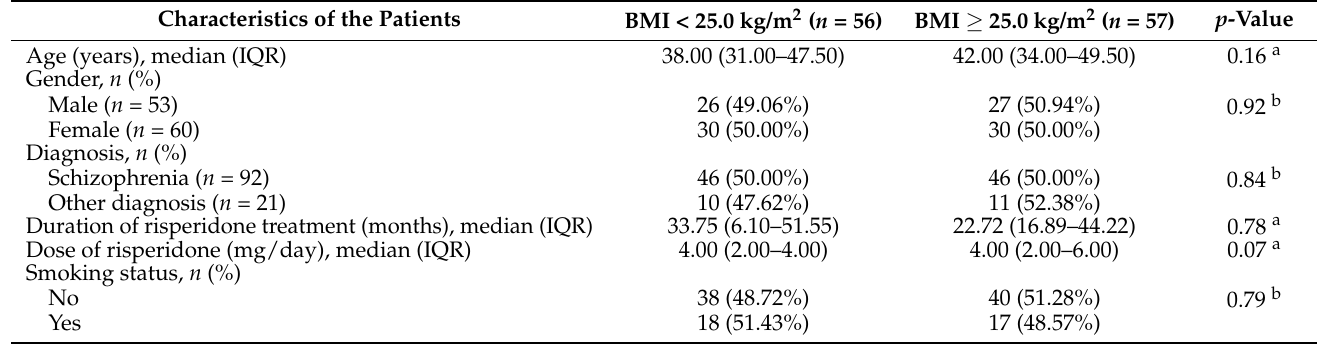
Table 2. Demographic and clinical characteristics ( n =